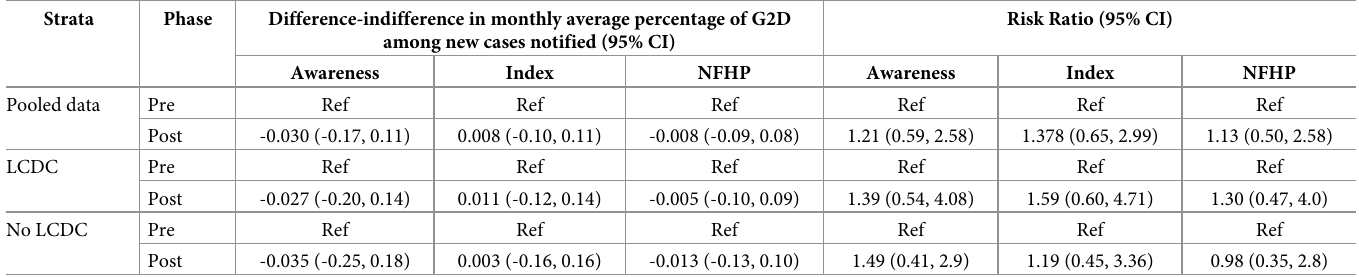
Table 4. Difference-in-difference in monthly average percentage of grade 2 disability among new cases notified during intervention period as compared to pre intervention period across intervention blocks after adjusting for control blocks and its ratio. Strata